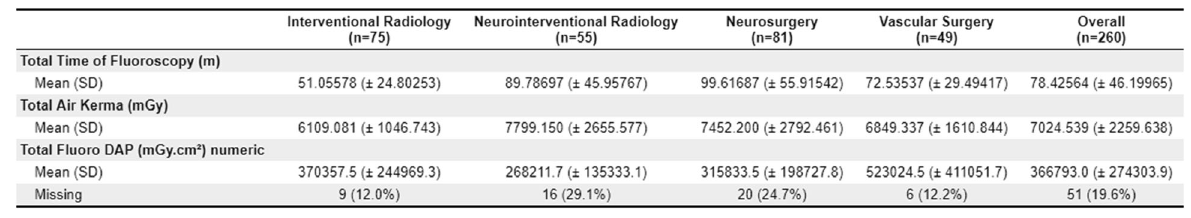
Table 2 Distribution of high dose procedures by medical discipline and the mean FT, DAP, and K a,r.. Statistical significance level is